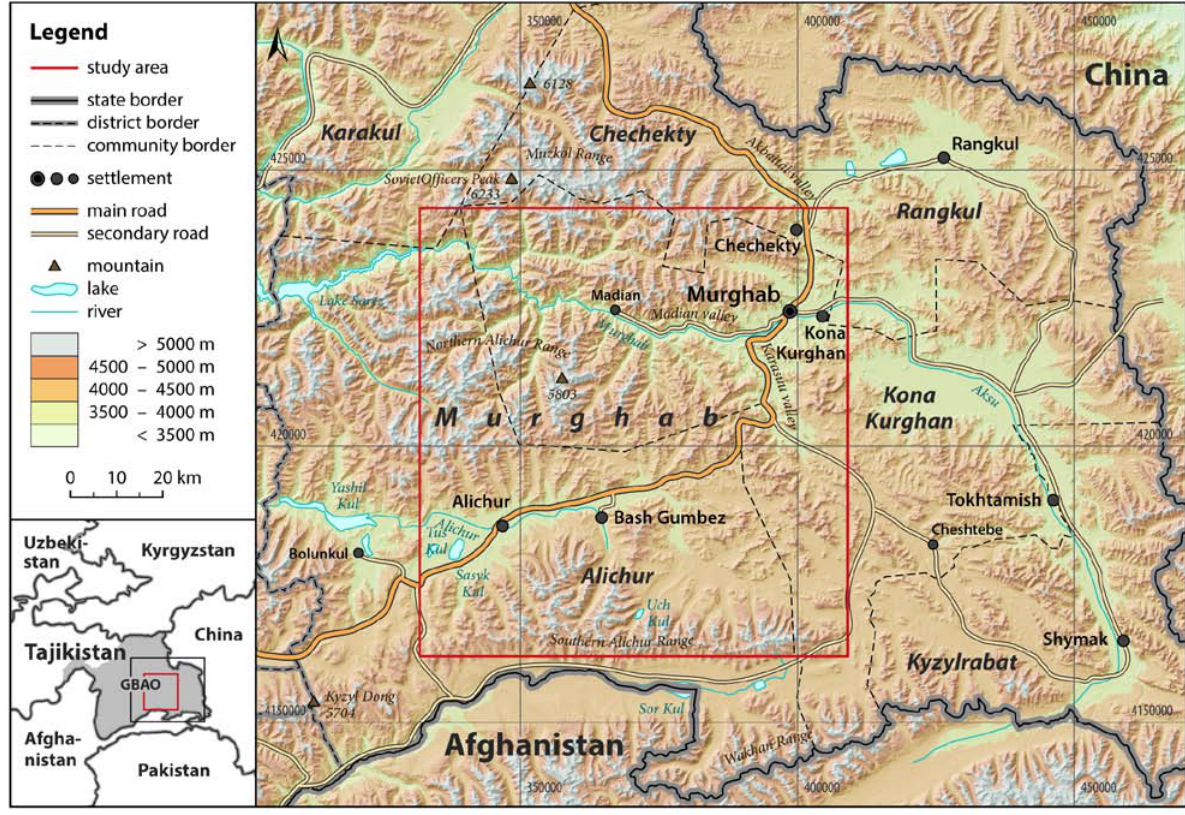
Figure 1. Overview of the study